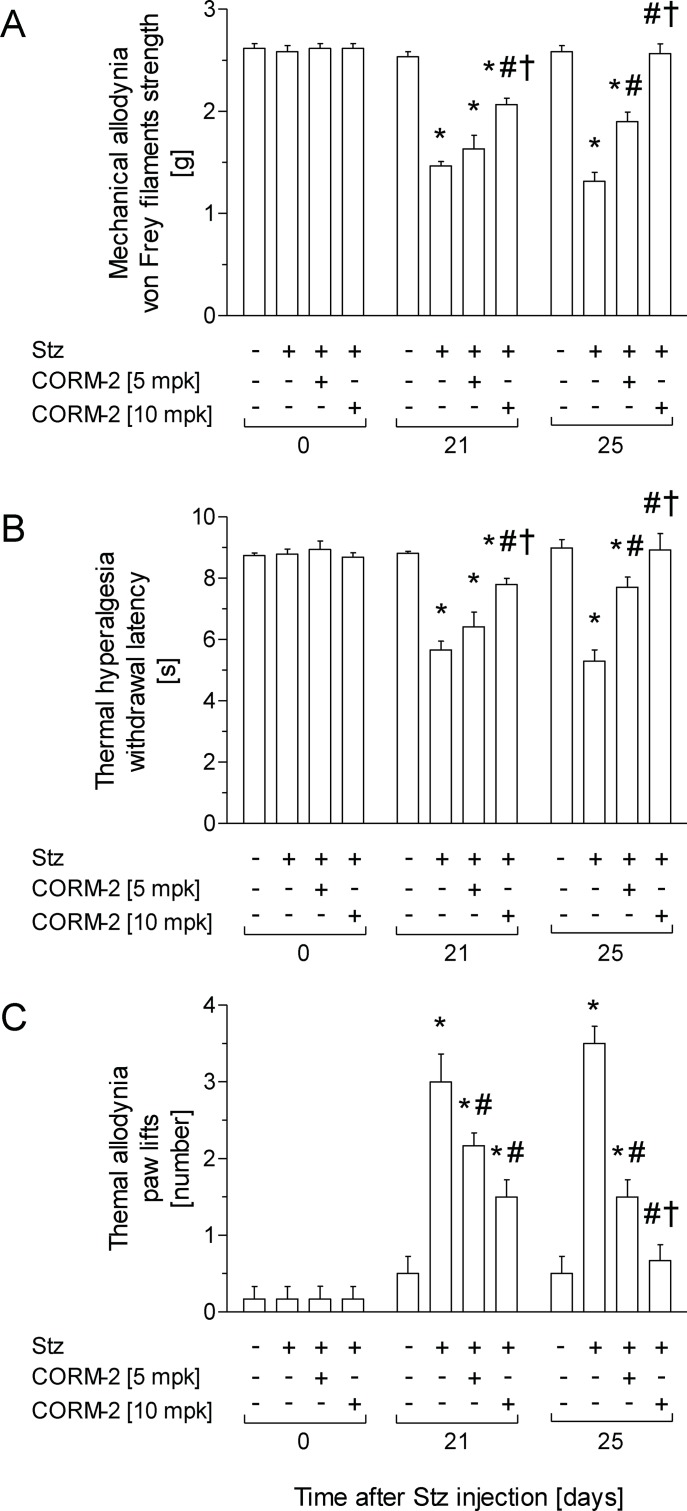
The administration of CORM-2 alleviates signs of neuropathic pain displayed by diabetic mice.Antinociceptive effects produced by the intraperitoneal administration of CORM-2 at 5 or 10 mg/kg in STZ injected mice. Results are shown as the mean values ± SEM; n = 6 animals per group. The development of mechanical allodynia (A), thermal hyperalgesia (B) and thermal allodynia (C) in the hind paws of control and diabetic mice intraperitoneally treated with vehicle or CORM-2 at 5 or 10 mg/kg is represented. Data of tests are shown at day 0 (before diabetes induction) and at days 21 and 25 after Stz injection (one and five days after initiation of CORM-2 administration, respectively). For each test and day, * indicates significant differences vs. Ctrl-vehicle, # vs. Stz-vehicle treated mice and † vs. Stz mice treated with 5 mg/kg CORM-2 (p < 0.05, one-way ANOVA followed by a Student-Newman-Keuls test). CORM-2, (tricarbonyldichlororuthenium(II) dimer; Ctrl, control mice; Stz, streptozotocin treated mice.